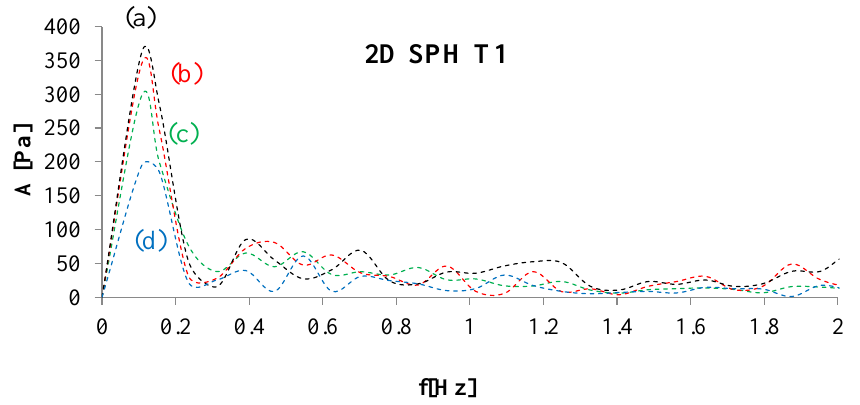
( a ) 7 cm; ( b ) 10 cm; ( c ) 20 cm; and ( d ) 100 cm, from the time-averaged position of the hydraulic